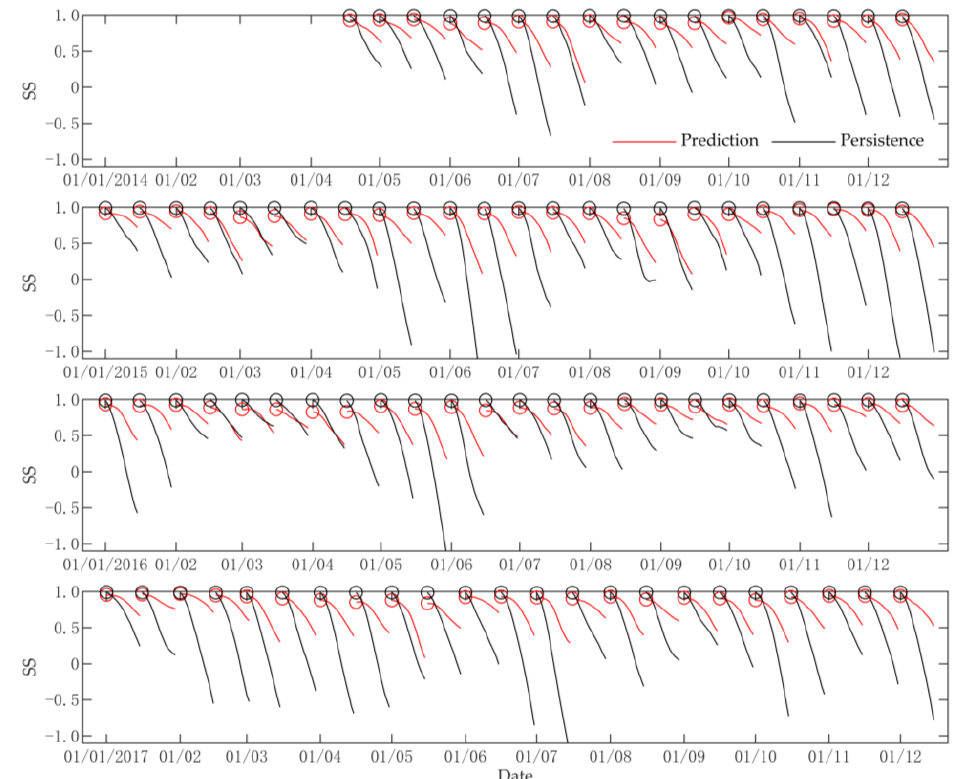
Figure 9. Skill score comparison of SLA between prediction (red) and persistence (black). The circle represents the position of day 1. The prediction time is 15 days. Circles are plotted every 15 days.